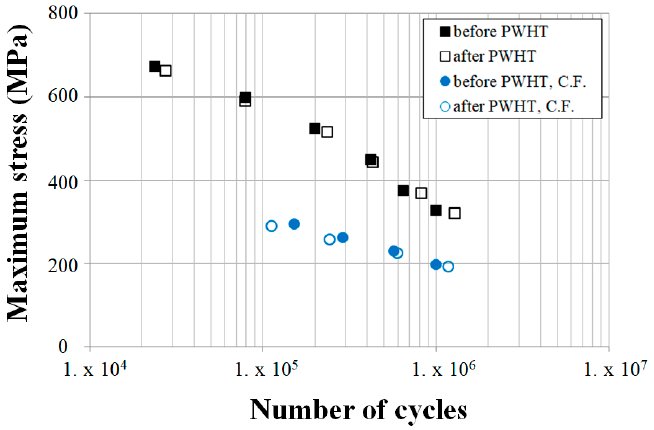
Figure 8. Comparison of fatigue and corrosion fatigue strength between prior to and after PWHT.